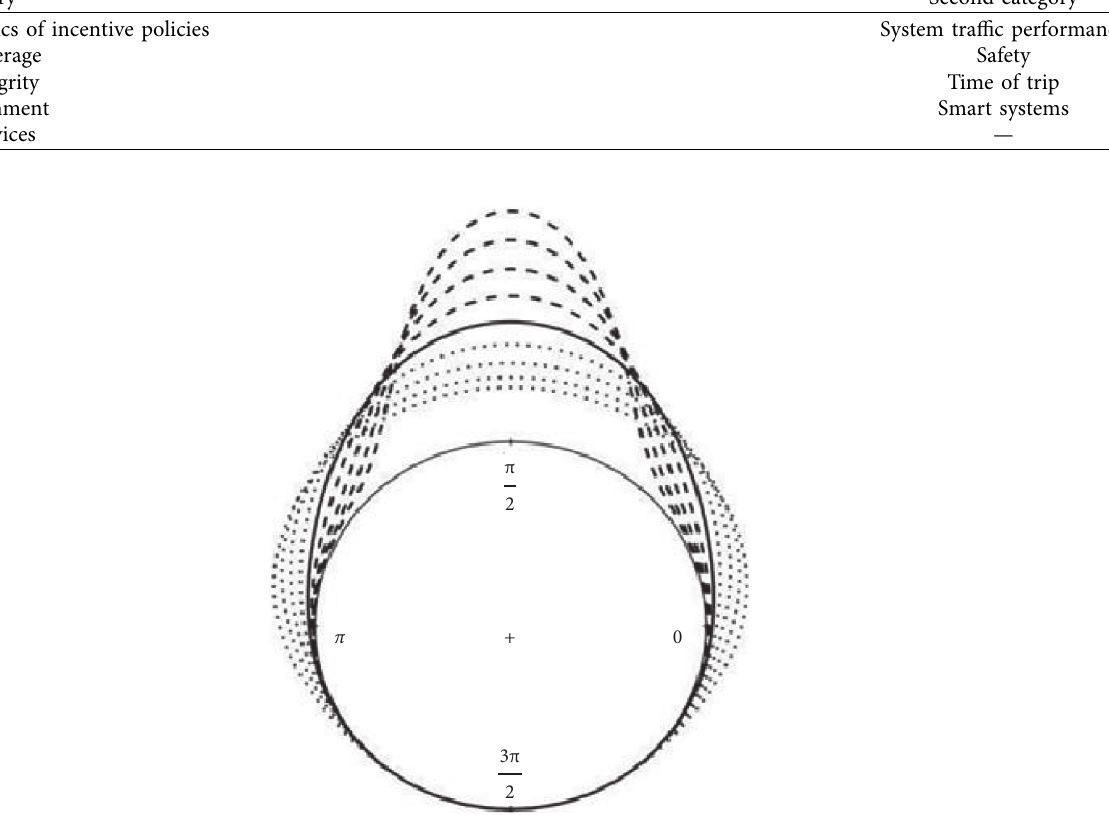
Figure 3: Functional classification of indicators for